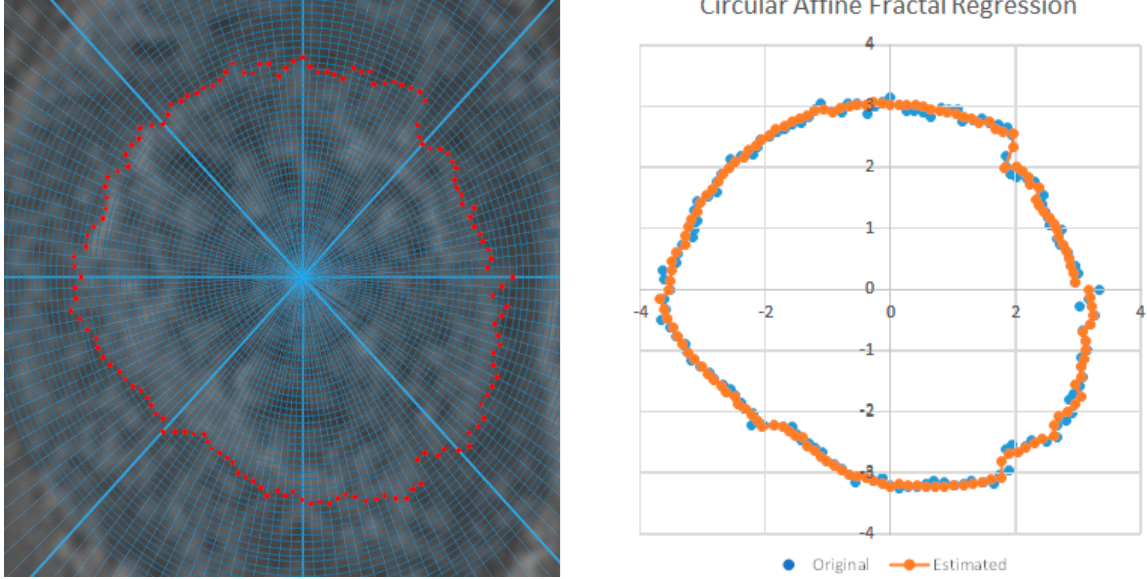
Figure 7. Zoomed image with the red contour points marked and the estimated fractal curve.